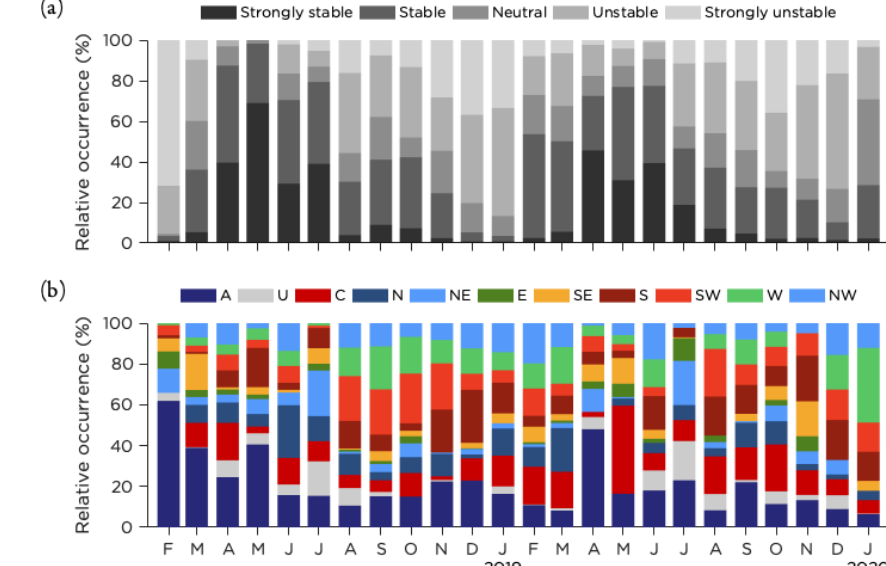
Figure 4. Monthly occurrence rate of (a) the boundary layer stratification based on data from the two lowest model levels in AROME forecasts and (b) the synoptic situation using a reduced set of 11 LWTs during the time period